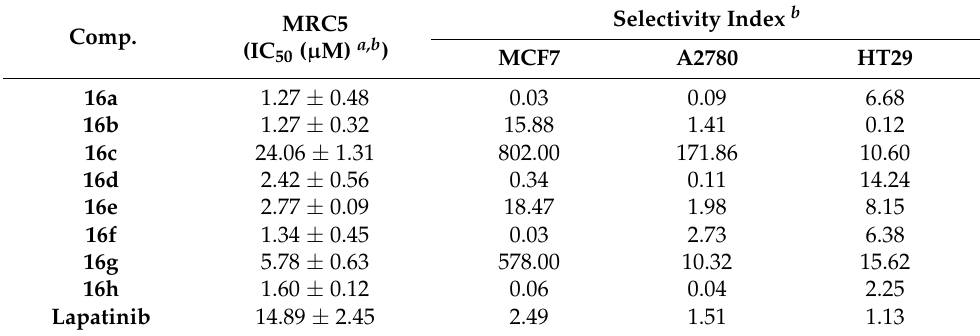
Table 3. Antiproliferative activity of compounds 10 , 16a – h , and lapatinib against MRC5 cells.